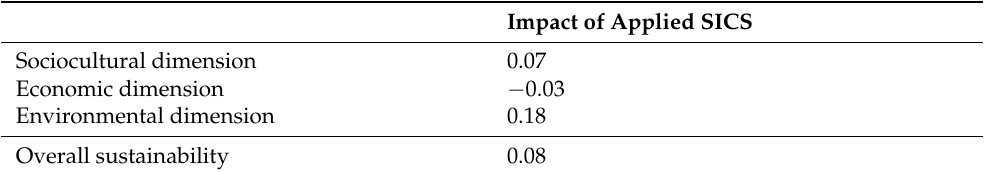
Table 7. Synthesis of the impact of applied SICS